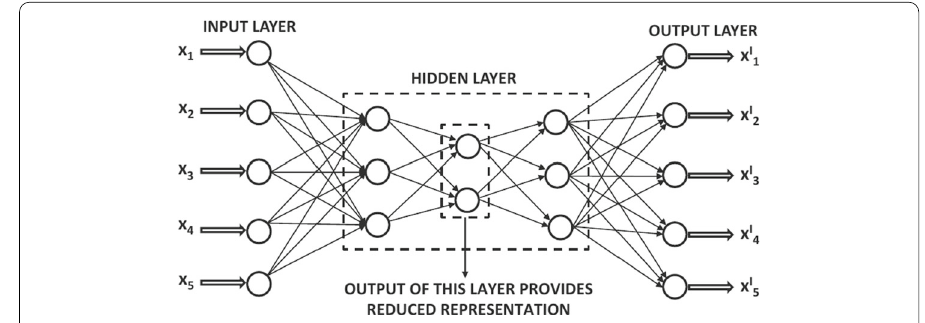
Fig. 5 Multi-Layer-Network, from [12] with input. 3 hidden and output layers